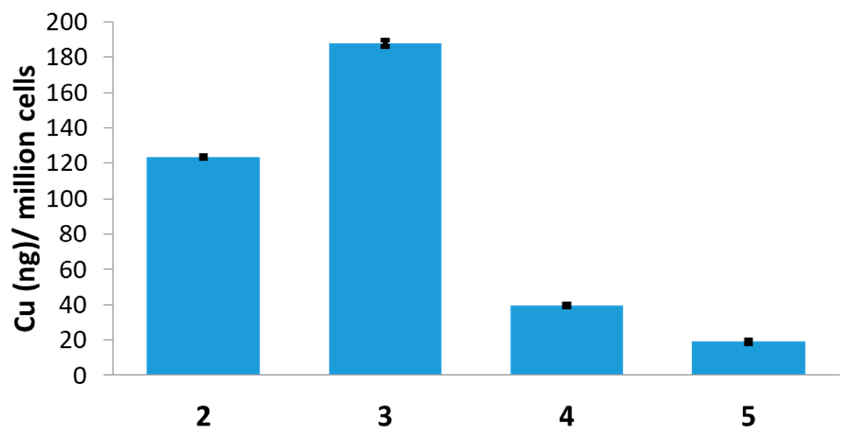
Figure 4. Copper content (ng of Cu/10 6 cells) in HMLER-shEcad cells treated with 2 – 5 (5 µ M for 24 h).